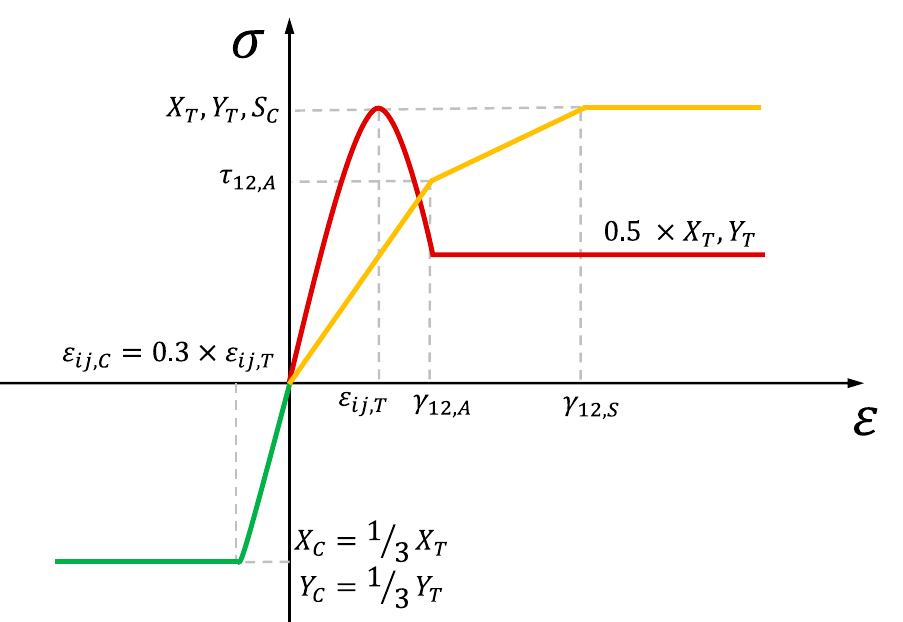
Figure 4. General behavior of *MAT_058 in tension (red), compression (green) and shear (yellow) as used for wood modeling in this work. Table 2. Calibrated material parameter in tensile loading direction for EW and LW obtained in [2].